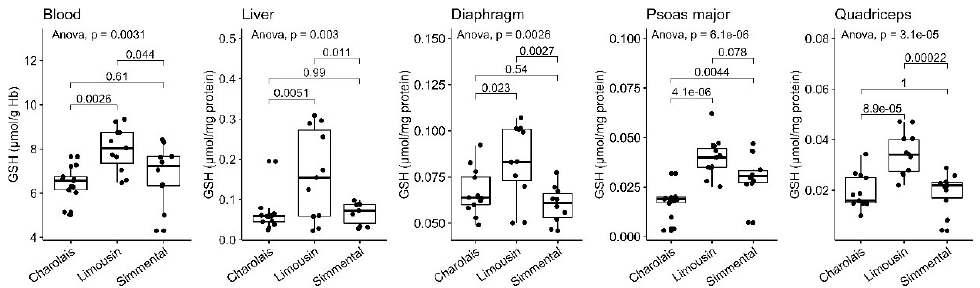
Figure 1. GSH levels in the blood, liver, diaphragm, quadriceps and psoas major of CHA, LIM and SIM cattle.